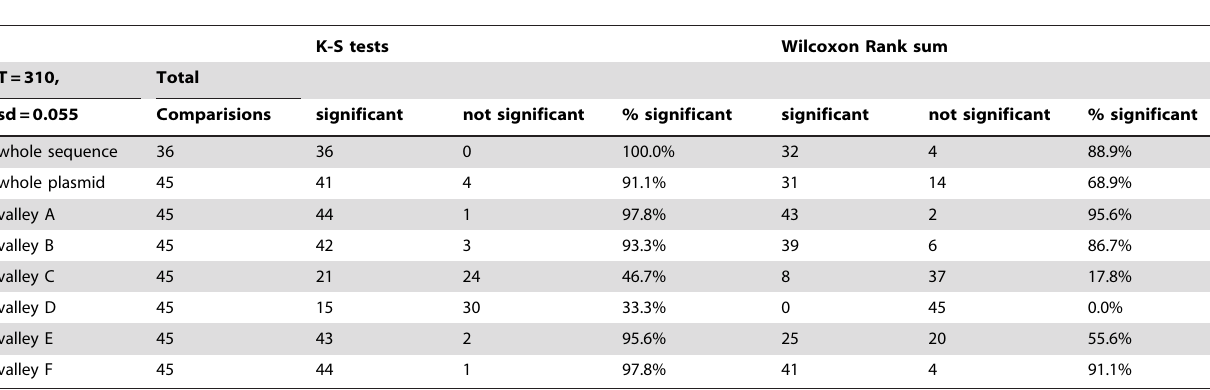
Table 1. Results of Kolmogorov-Smirnov and Wicoxon Rank Sum tests, at the 5% significance level, using the pair-wise comparisons of the distribution of the G ( x ) energies.